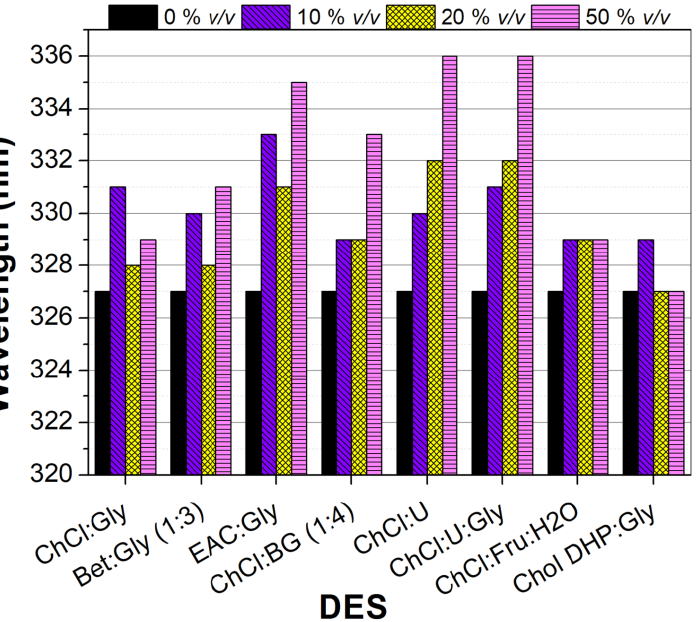
Figure 8. Maximum emission wavelength ( λ max ) of free tyrosinase’s fluorescence emission spectra, for increasing concentrations of various DESs.